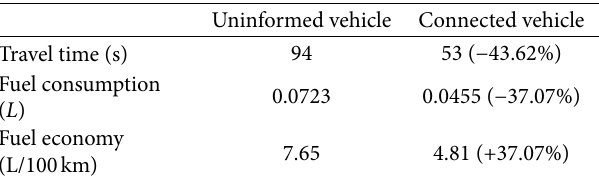
Table 3: Fuel consumption and travel time of the connected vehicle and the uninformed vehicle.